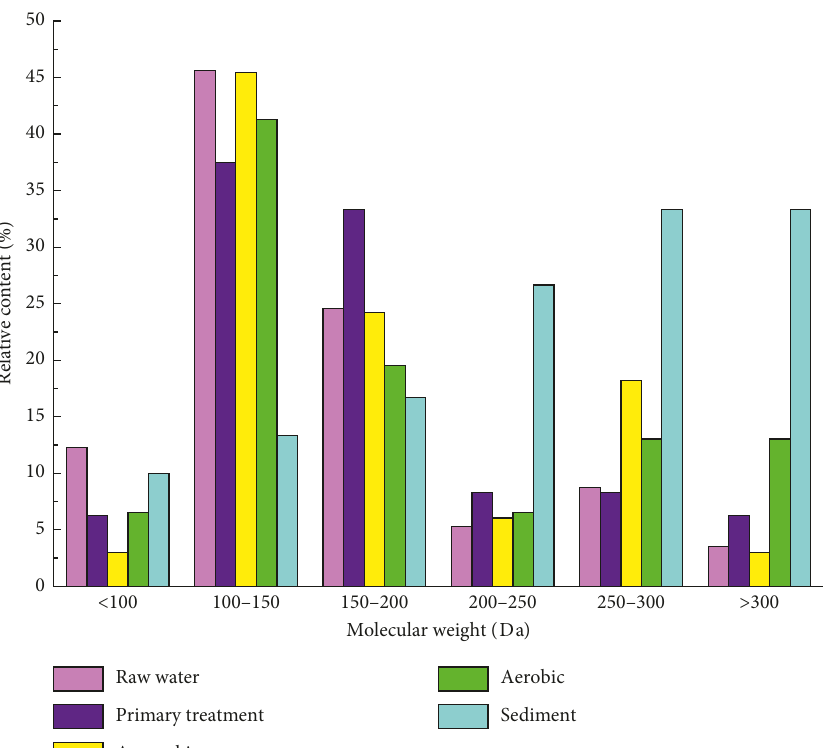
Figure 7: Relative distributions of molecular weight classes during each stage of a typical traditional treatment